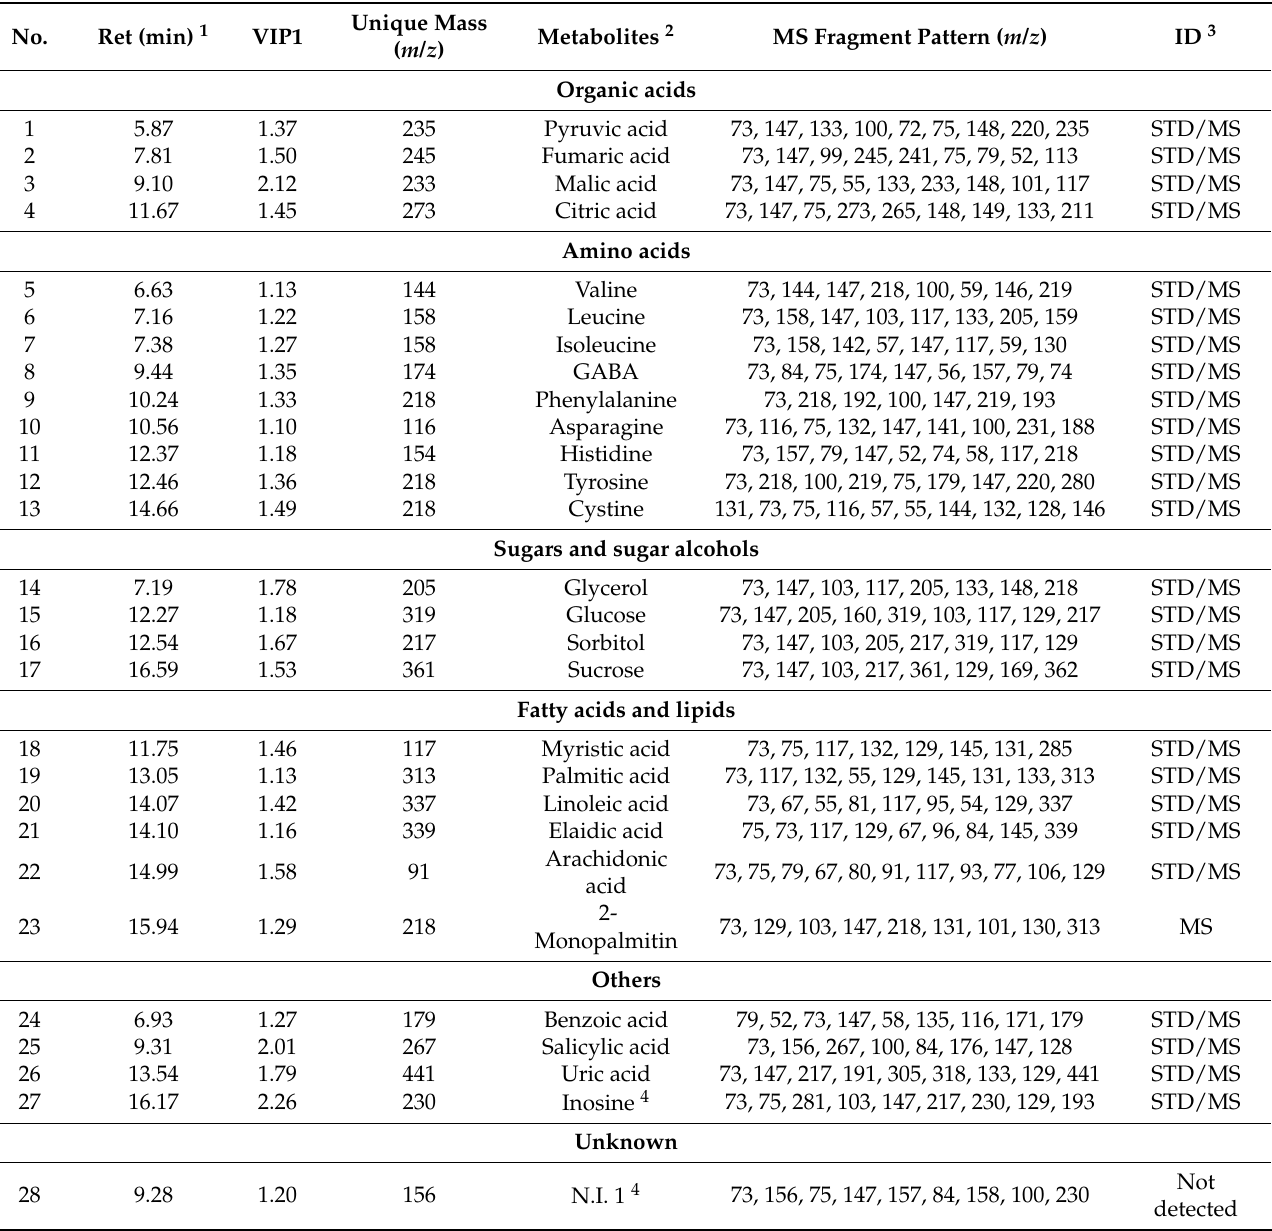
Table 2. Distinguished metabolites among the current infection, past infection, and no infection history groups analyzed by